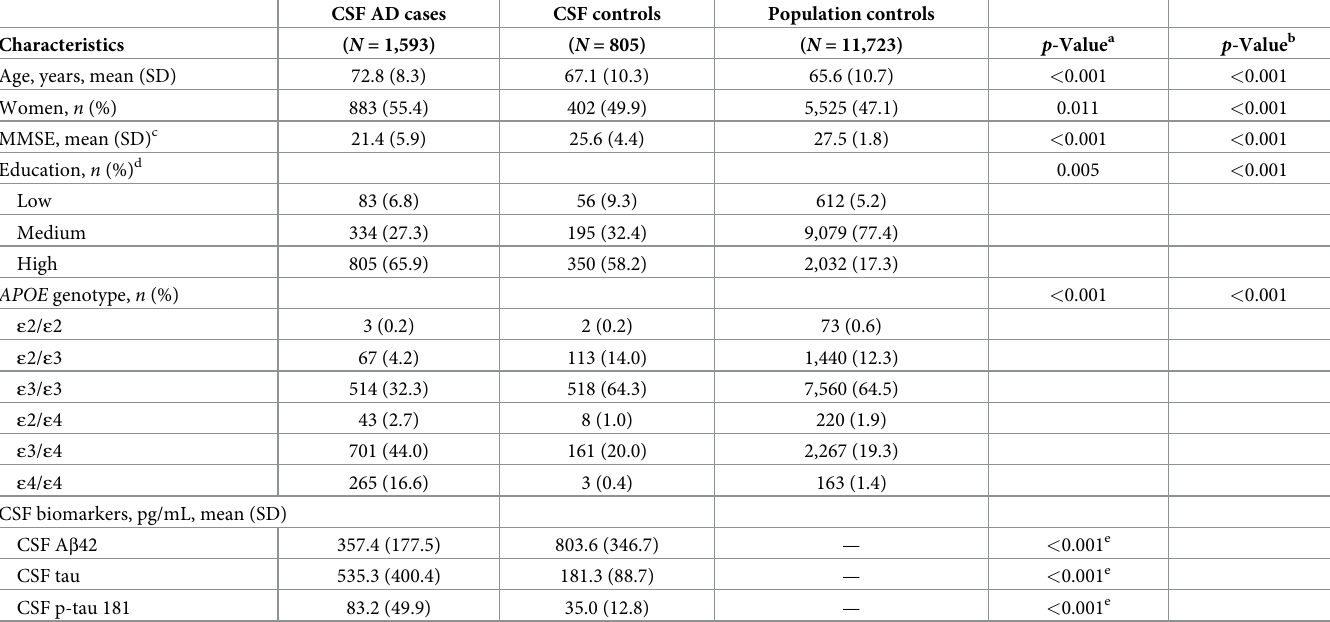
Table 1. Characteristics of the study population: CSF-determined AD cases, CSF-determined controls, and population controls. CSF AD cases CSF controls Population